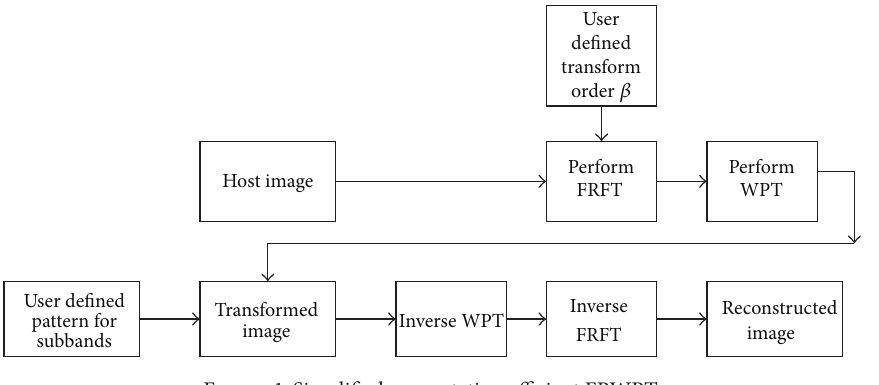
Figure 1: Simplified computation efficient FRWPT.